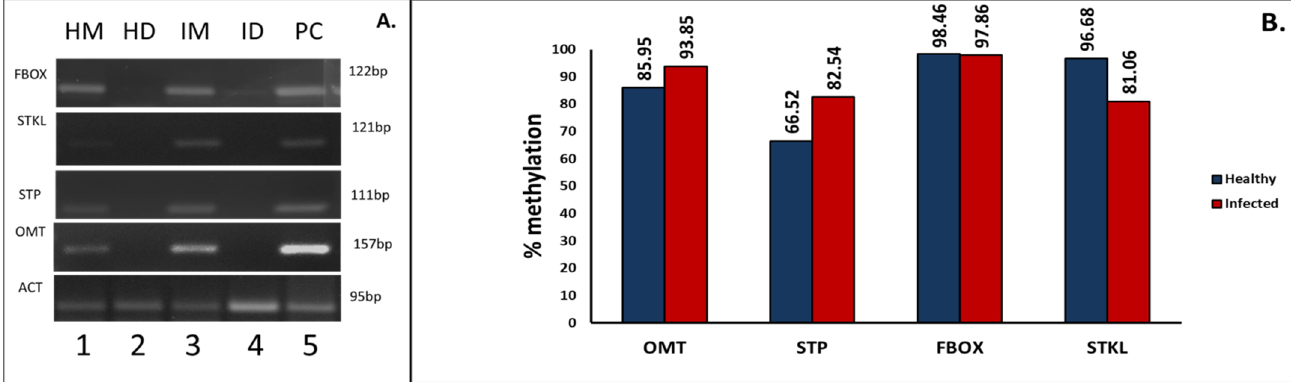
Figure 10. Analysis of the hypo- or hypermethylation status of selected loci namely, F-box protein PP2-B15 (FBOX), STOREKEEPER protein-like (STKL), Probable O methyltransferase 3(OMT) and serine/threonine-protein phosphatase 7 long form homolog (STP). ( A ) PCR amplicons obtained using respective primers in samples digested with McrBC enzyme for 16 h.Actin (ACT), an unmethylated control showed amplification in both mock and digested samples. HM-Healthy Mock, HD-Healthy Digested, IM-Infected Mock and ID-Infected Digested and C- Positive Control. ( B ) Graph showing percentage methylation of designated CpG Islands on the loci was calculated using ΔΔ Ct.